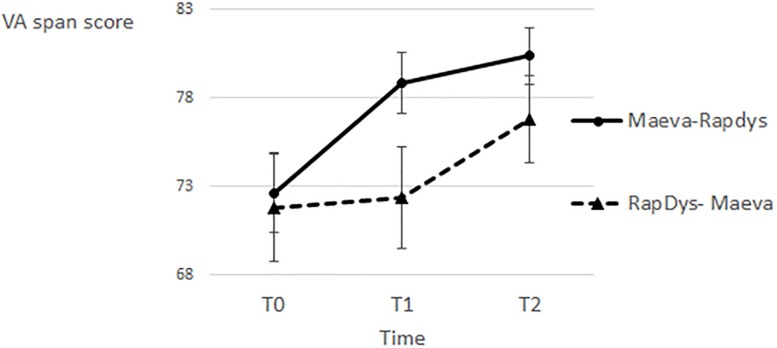
Visual attention span scores for each time period and each presentation order.